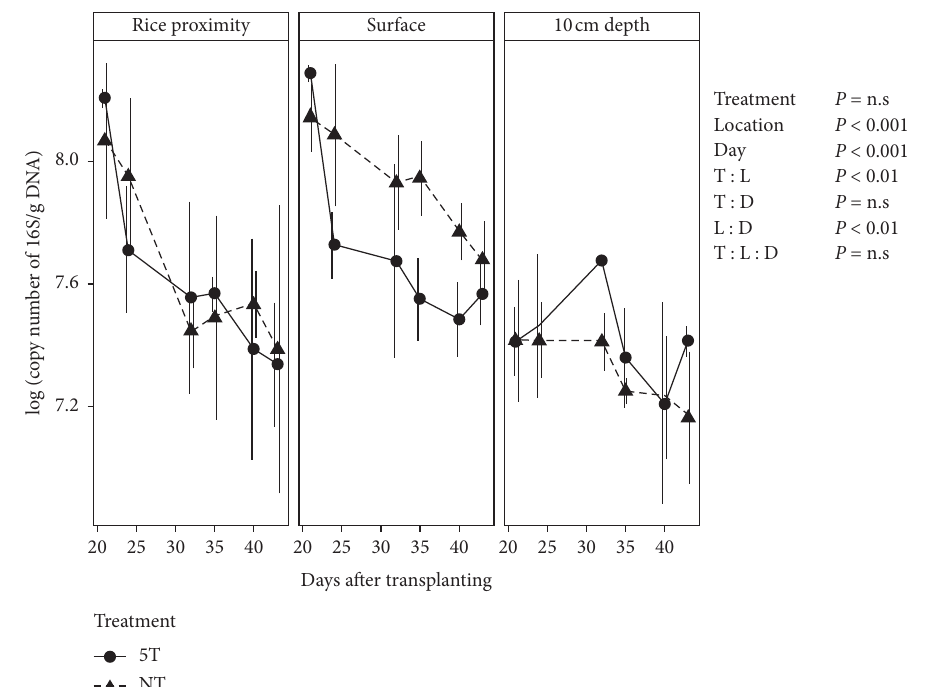
Figure 1: The time course changes of 16S bacterial abundance under no tillage (NT) and 5 times tillage (5T) at three different locations (rice proximity, surface, and 10cm depth) after transplanting. Level of significance was determined by and two-way ANOVA. Error bars indicate standard deviations ( n � 3).